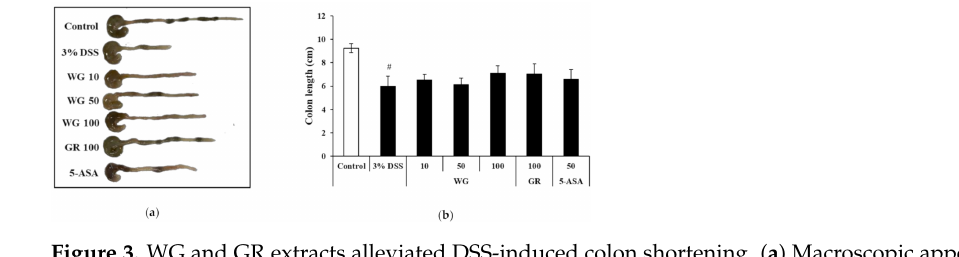
Figure 3. WG and GR extracts alleviated DSS-induced colon shortening. ( a ) Macroscopic appearance of colon. ( b ) Length of colon. Data are expressed as mean ± SEM ( n = 6/treatment) (#: p < 0.05 vs. control; *: p < 0.05 vs. DSS only).